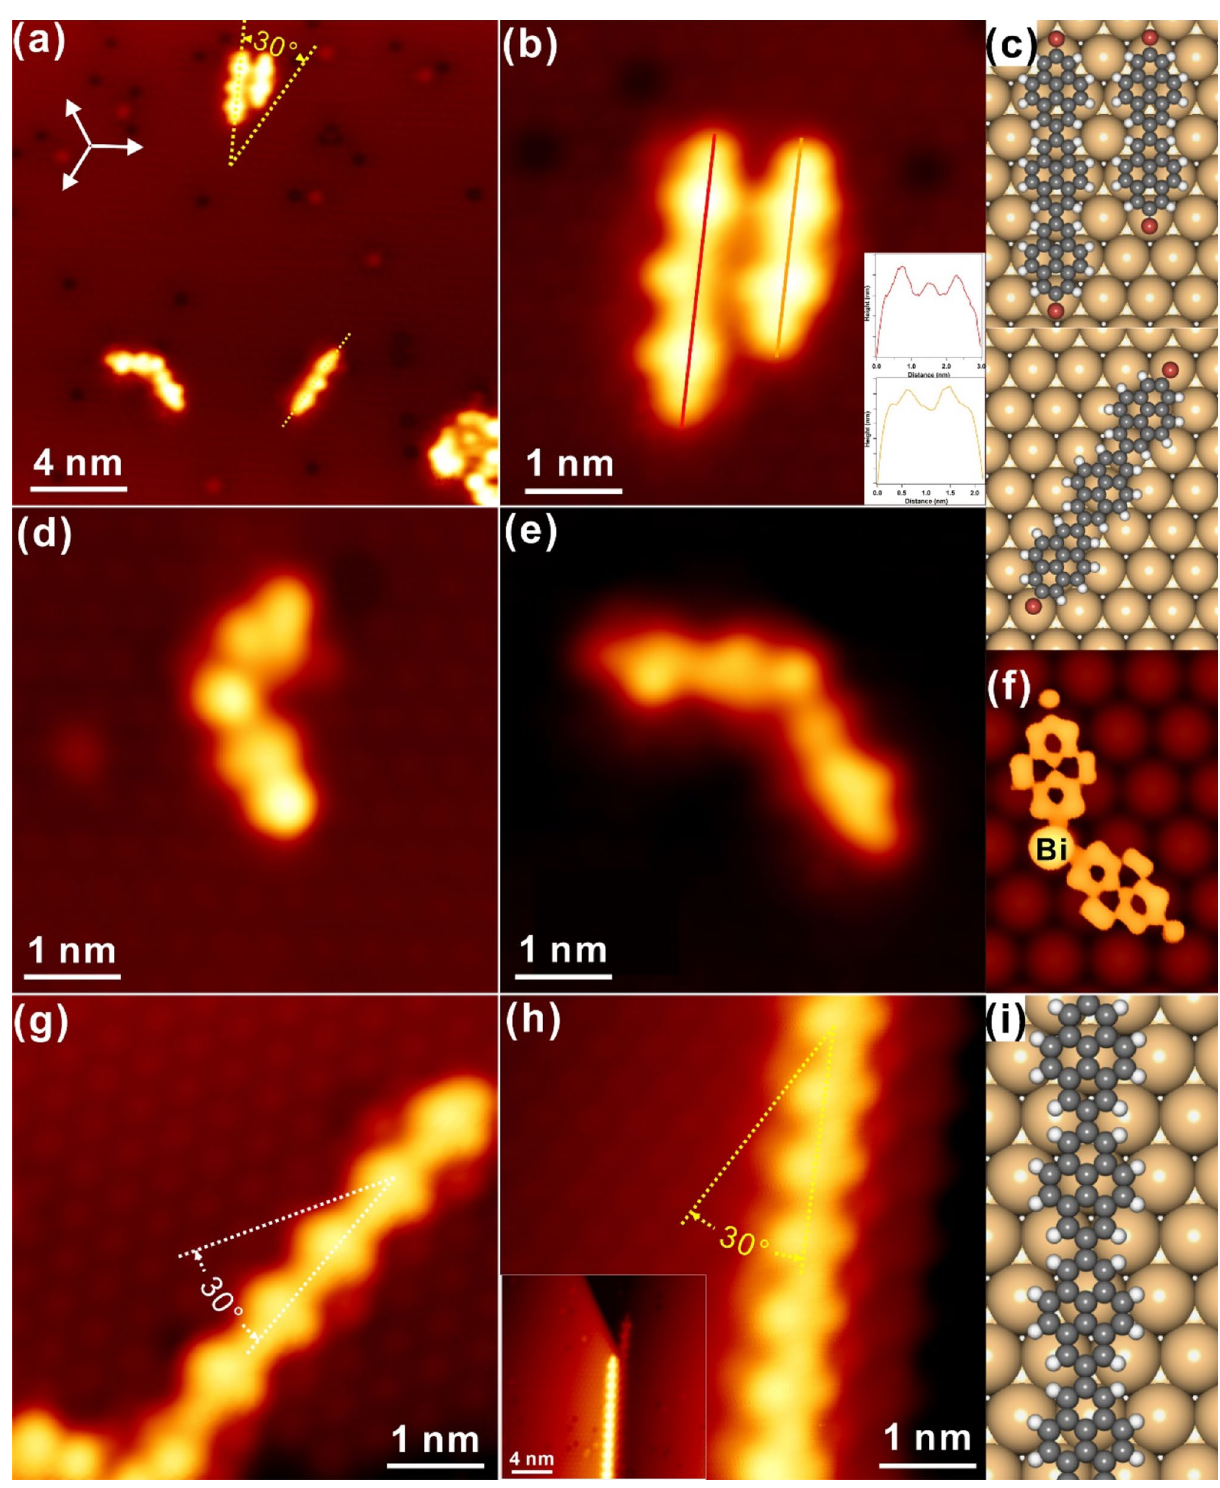
Figure 2. STM images recorded with step-wise annealing. (a) Surface topology after annealed to 380 K with the zoom-in image presented in (b) . (c) Optimized adsorption configurations for dimers and trimers observed in (b) . (d,e) Nonlinear dimer and tetramer formed after annealing to 380 K. (f) STM simulation (bias: − 1.5 V) of the zig-shaped dimer with Bi bound in middle from (d) . (g) The extended oligomer found after 410 K annealing. (h) Formation of polymer chain with annealing to 440 K and the large-scale image shown inset. (i) DFT optimized model for the polymer chain in (h) . Scanning parameters: U bias = − 1.5 V, I t = 0.3